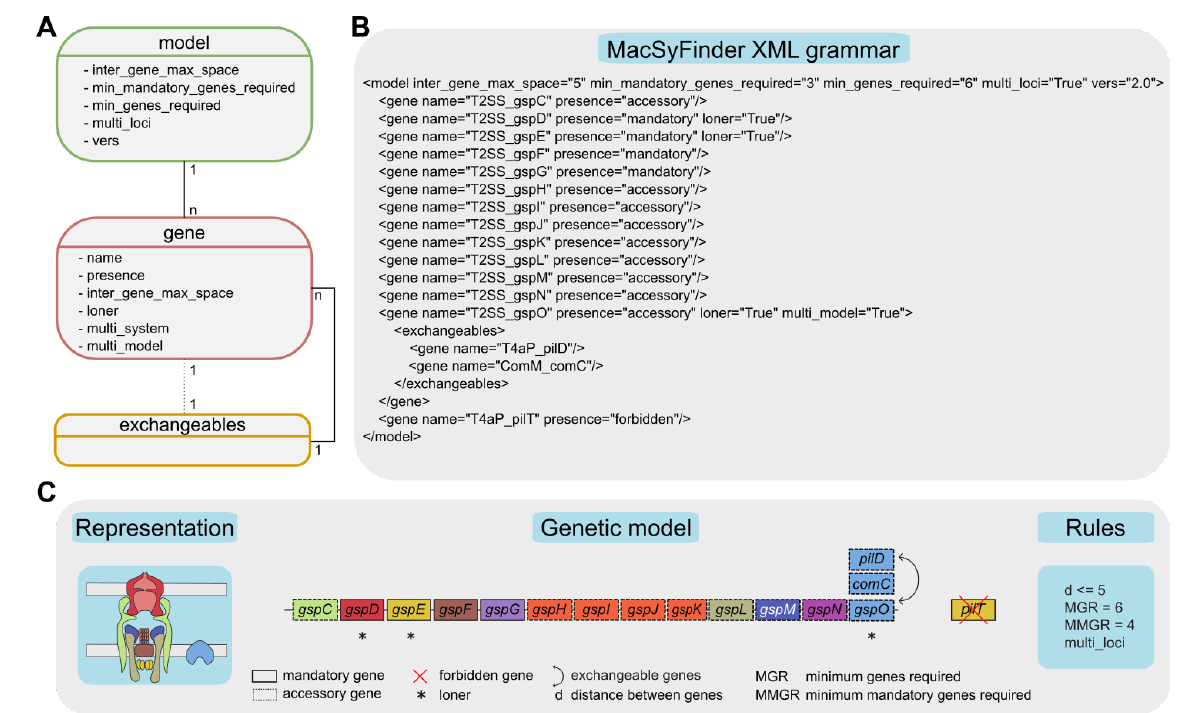
Figure 3 - Description of the hierarchical grammar used in MacSyFinder models and example of the T2SS model. A. The “model” is the root element of the XML document according to the grammar. It represents the system to model and contains at least one element “gene”. The “gene” element describes the genes constituting a system. It may contain one element “exchangeables”. The dashed line between “gene” and “exchangeables” illustrate the fact that a gene does not necessary contain an “exchangeables” element. The “exchangeables” element contains a set of genes (one at least) that can replace functionally the parent “gene” in the system quorum. The one-to-many relationships between the different elements is represented by lines connecting the boxes, with the cardinality of the relationship appearing next to the element. The diverse possible features of each element are represented in the corresponding boxes. B. XML grammar of the T2SS from TXSScan v1.1.1 (and TFFscan v1.0.1) (Abby et al., 2016; Denise et al., 2019). C. A schematic representation of the T2SS machinery spanning the membranes of a diderm bacterium is displayed on the left. The genetic model corresponding to the T2SS model in panel B is illustrated in the central part, with gene boxes filled with the colour of the corresponding proteins on the T2SS schema. The quorum and co-localization rules to fulfil the T2SS model are described on the right. Genes’ names were abbreviated in the genetic model compared to the names in the XML model. The C panel was derived from (Denise et al.,